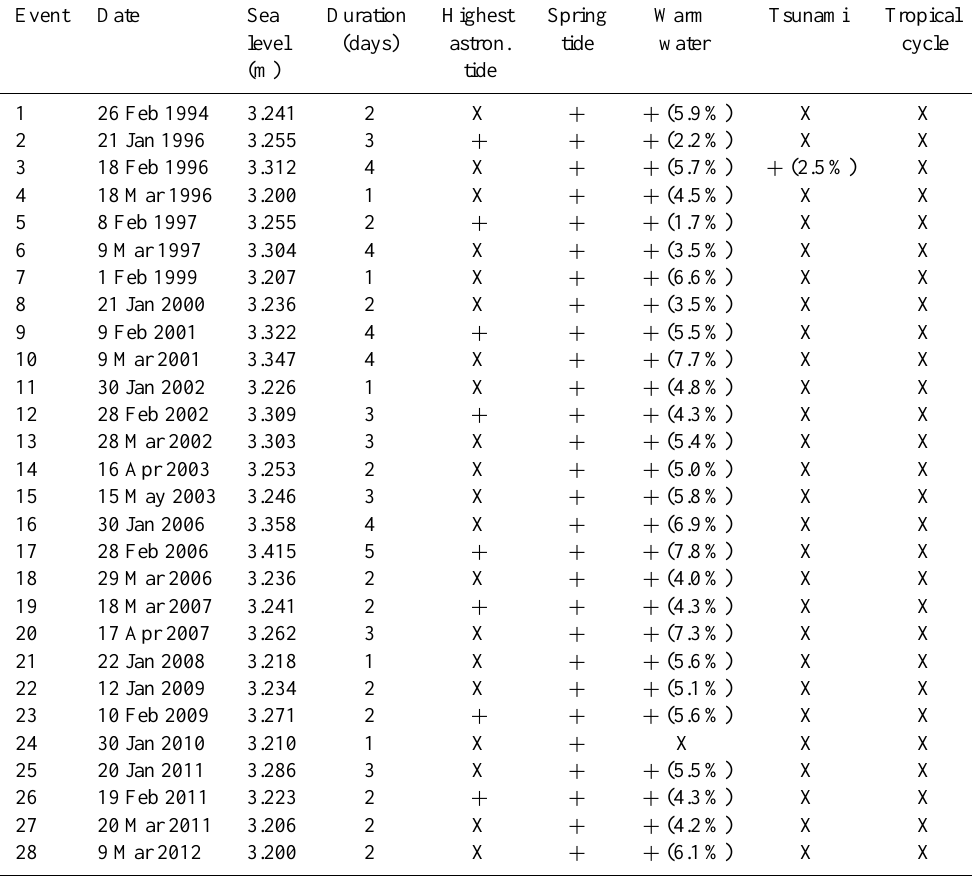
Table 1. A check list of possible influential factors of the 28 King Tide events.